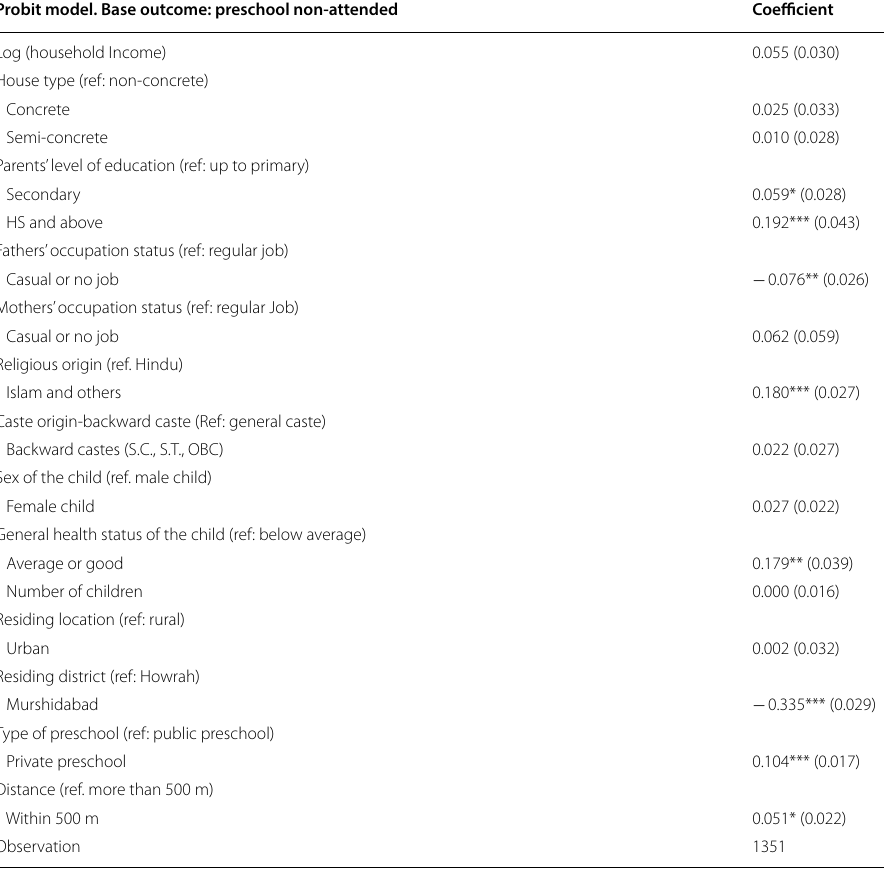
Table 4 Estimation of the selection